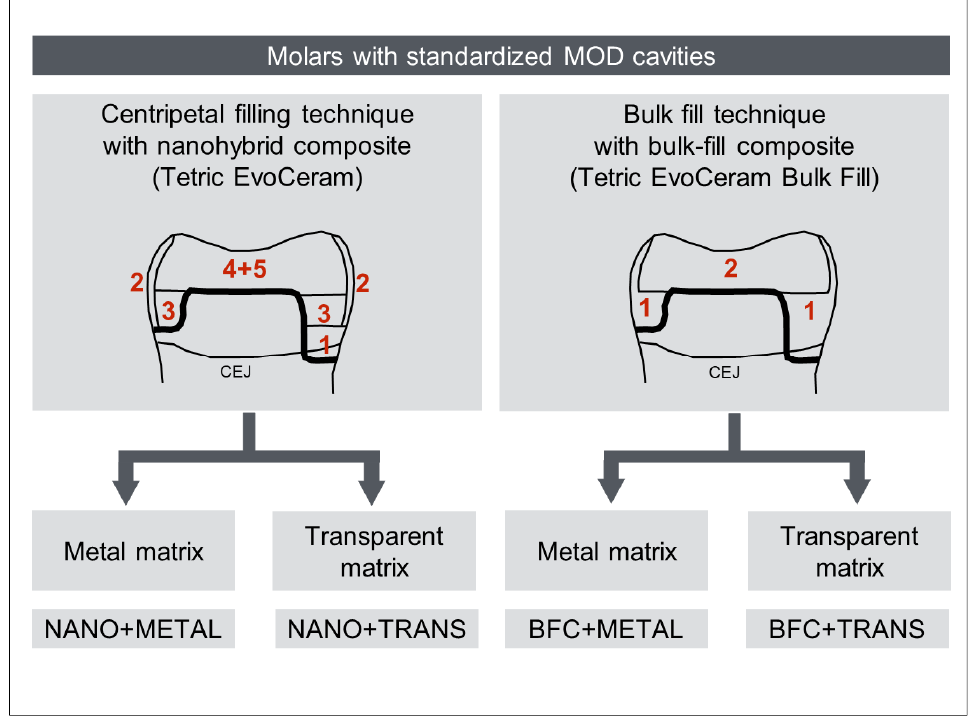
Figure 3. Experimental setup with the four experimental groups; red digits represent the order and number of composite increments. NANO = Tetric EvoCeram; BFC = Tetric EvoCeram Bulk Fill; METAL = metal matrix; TRANS = transparent matrix; CEJ = cementoenamel junction.